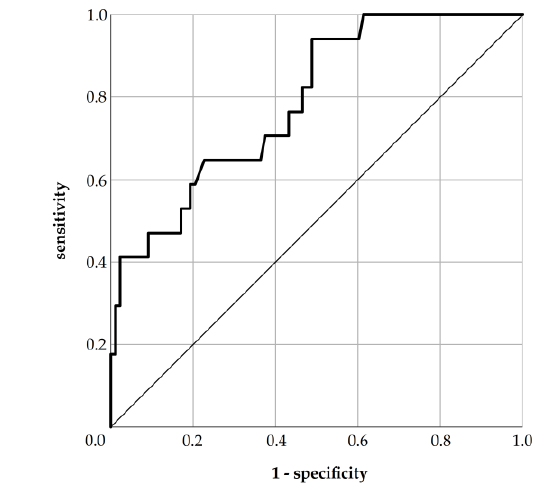
Figure A1. ROC analysis examining the relationship between the predicted probability of ICU stay and actual ICU admission. Table A1. Crosstabulation illustrating case assignment in our cohort by risk model.